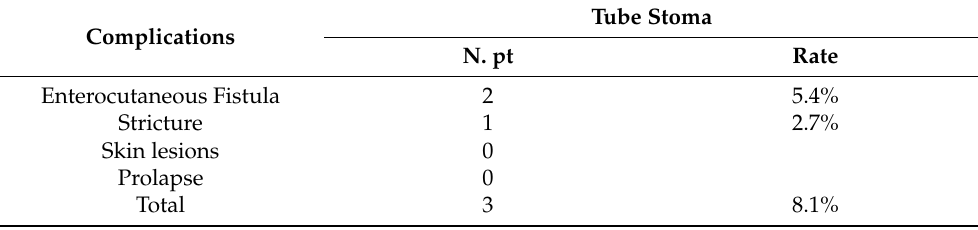
Table 1. Tube stoma complications were limited to three patients (8.1%), with two children (5.4%) requiring additional stoma surgery during the first 30 days because of an enterocutaneous fistula, and one child (2.7%) for bowel